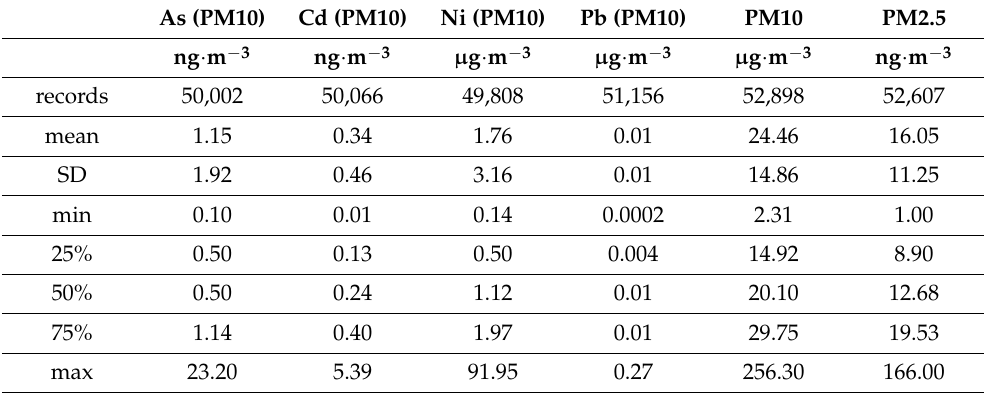
Table 1. Descriptive characteristics of air pollution of the analyzed area in 2020.